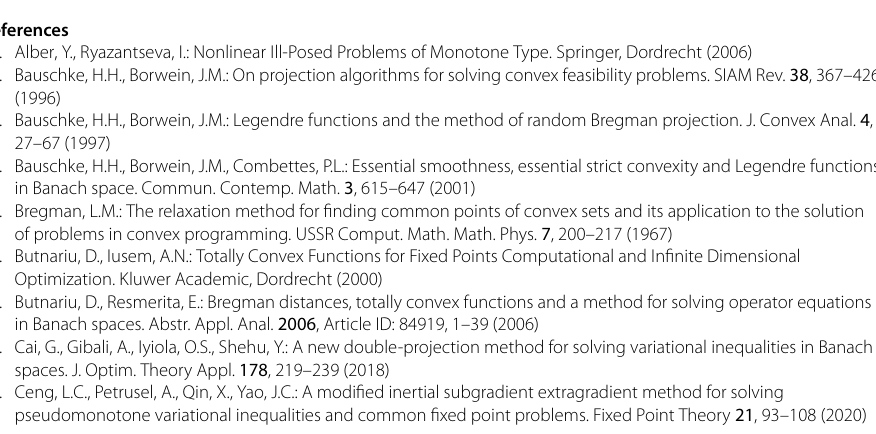
We plot the graphs of error ( (cid:10) x n +1 – x n (cid:10) (cid:15)